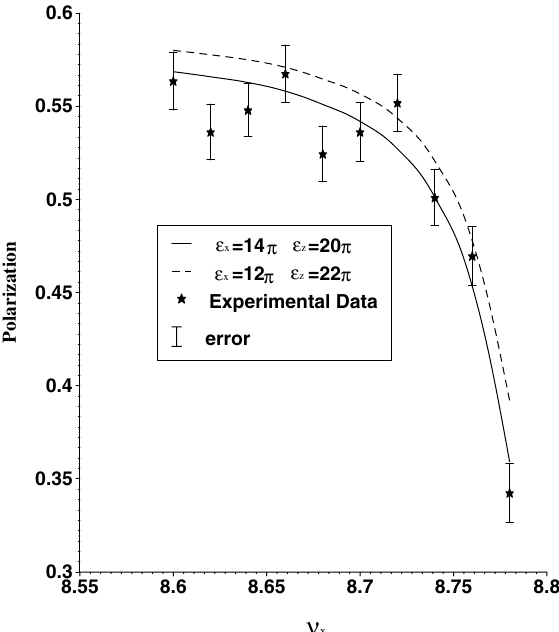
FIG. 4. Polarization after crossing the 0 (cid:5) (cid:28) resonances during acceleration with vertical and horizontal set-point normal mode tunes at (cid:28) currents of all six skew quadrupole magnets. Snake strength was 3%. The vertical and horizontal emittances were measured as (cid:4) 11 (cid:18) 1 (cid:6) $ and (cid:4) 21 (cid:18) 1 (cid:6) $ mm mrad . In addition, a distributed roll of < 0 : 3 mrad was applied to the BD and CF magnets in the curves calculated using DEPOL .